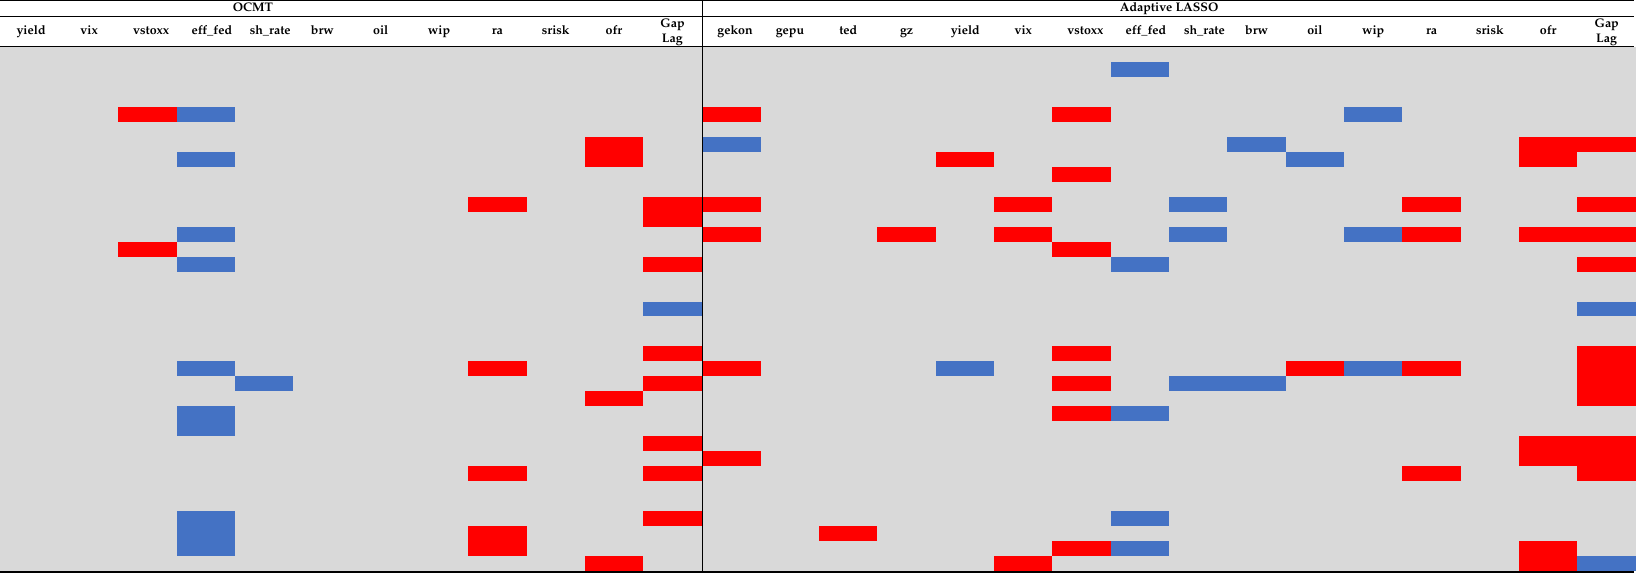
Table 4. Global determinants of credit-to-GDP gaps in